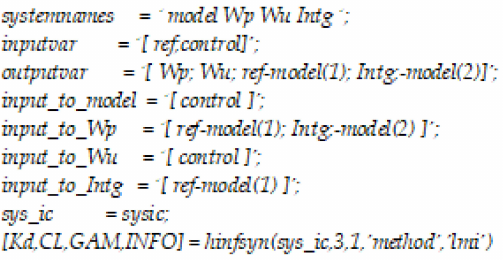
Figure 7. Source code for H ∞ controller design.